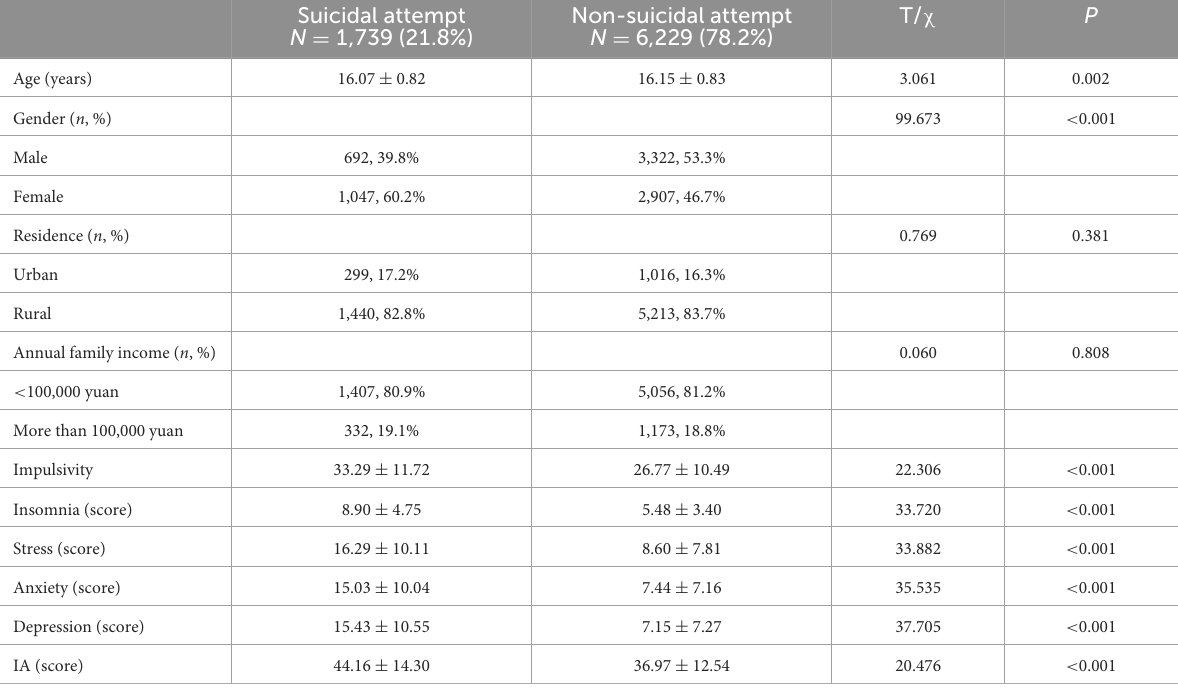
TABLE 3 Demographic data and characteristics of the population with and without suicidal